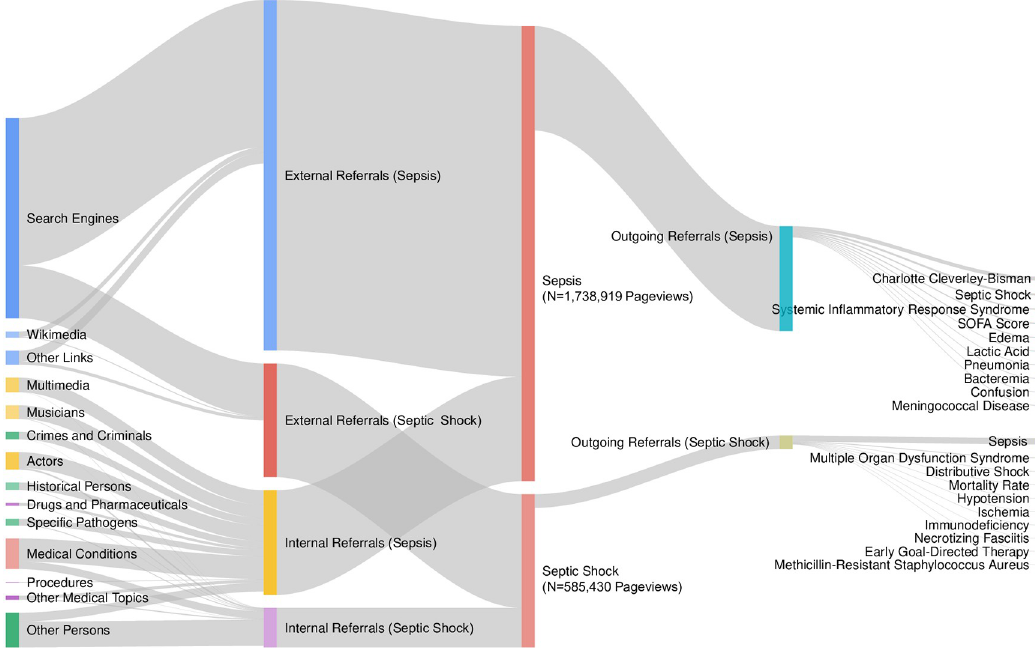
Fig 5. Sepsis and septic shock Wikipedia clickstream sankey diagram (November 2017 to June 2018). Owing to a large number of unique inbound linkages within Wikipedia, individual Wikipedia pages were aggregated into common categories (see Methods). Only the top 10 outbound Wikipedia pages are listed to improve legibility. Missing data are due to limitations in the underlying data, including refererless traffic from clients utilizing a HTTPS protocol. Source data are available in supporting files.